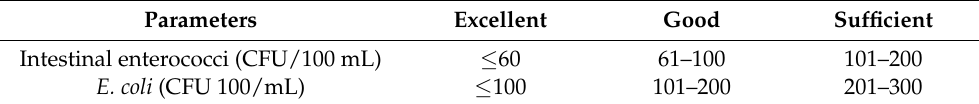
Table 6. Croatian standards for assessment of bathing water quality after each analysis.